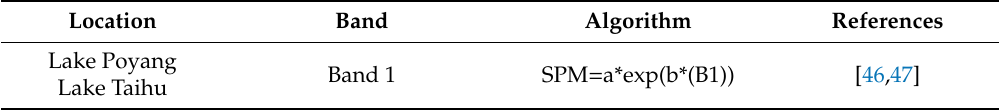
Table 2. Estimation of the suspended particulate matter (SPM) concentration using moderate resolution imaging spectroradiometer (MODIS) in the case-2 waters in